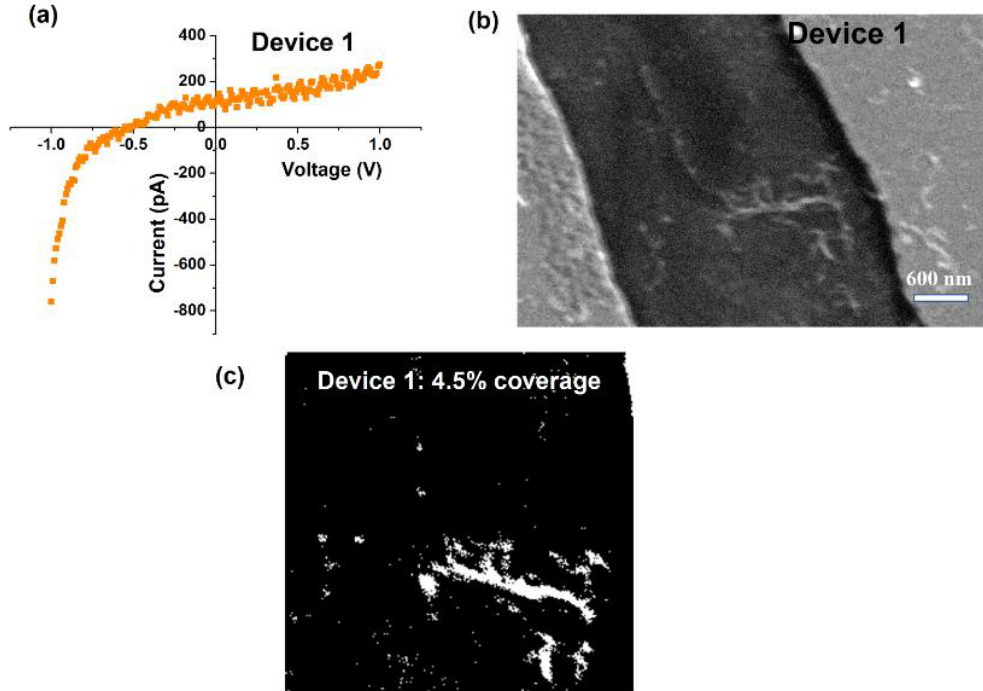
Figure 5. ( a ) Current-voltage behavior for device 1 showing negligible pA current, attributed to leakage across the surface, ( b ) SEM image of device 1 showing the two metal contacts and a very low concentration of MWCNTs in the 6 µ m 2 channel area, ( c ) Binary image of the SEM image shown in ( b ) with an estimated 4.5% of the channel area covered by